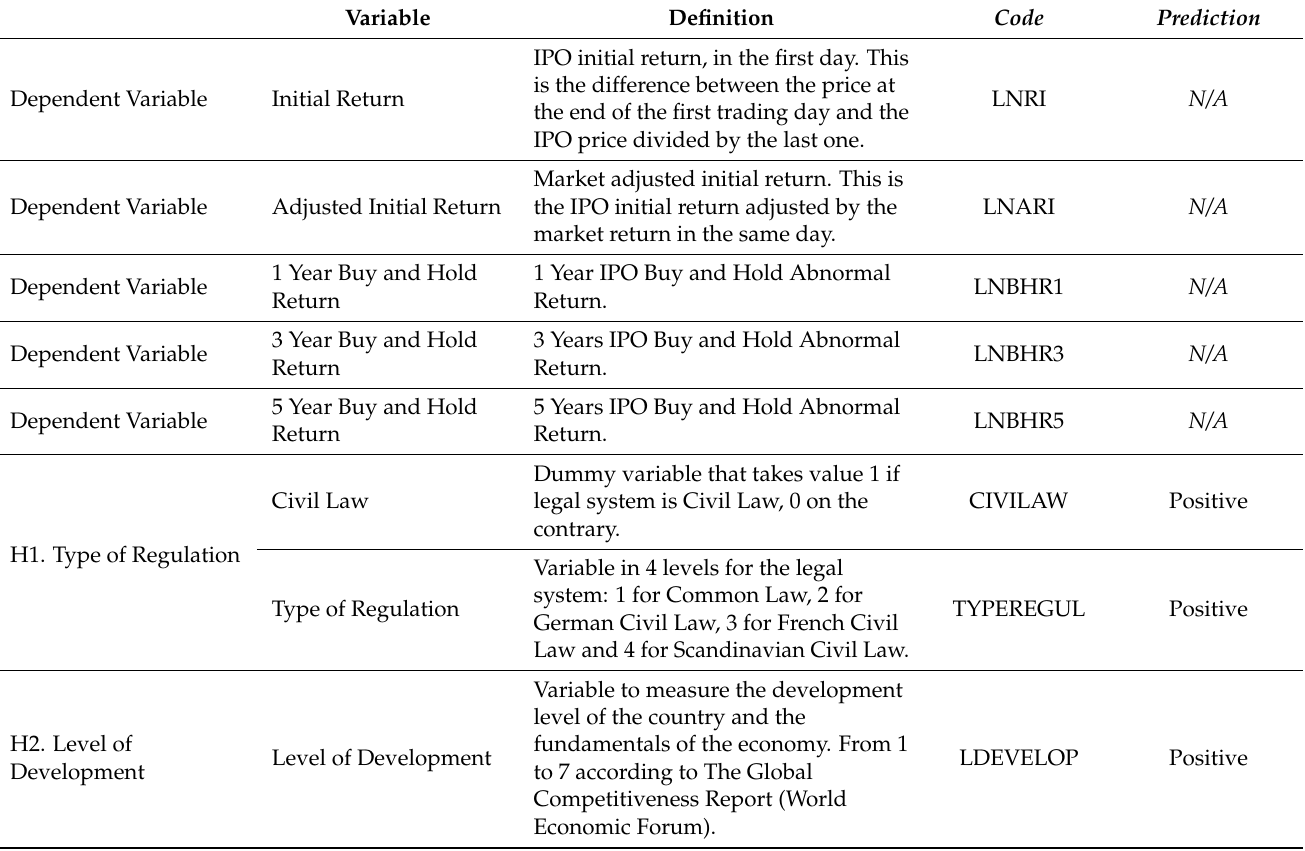
Table 3. Hypotheses and